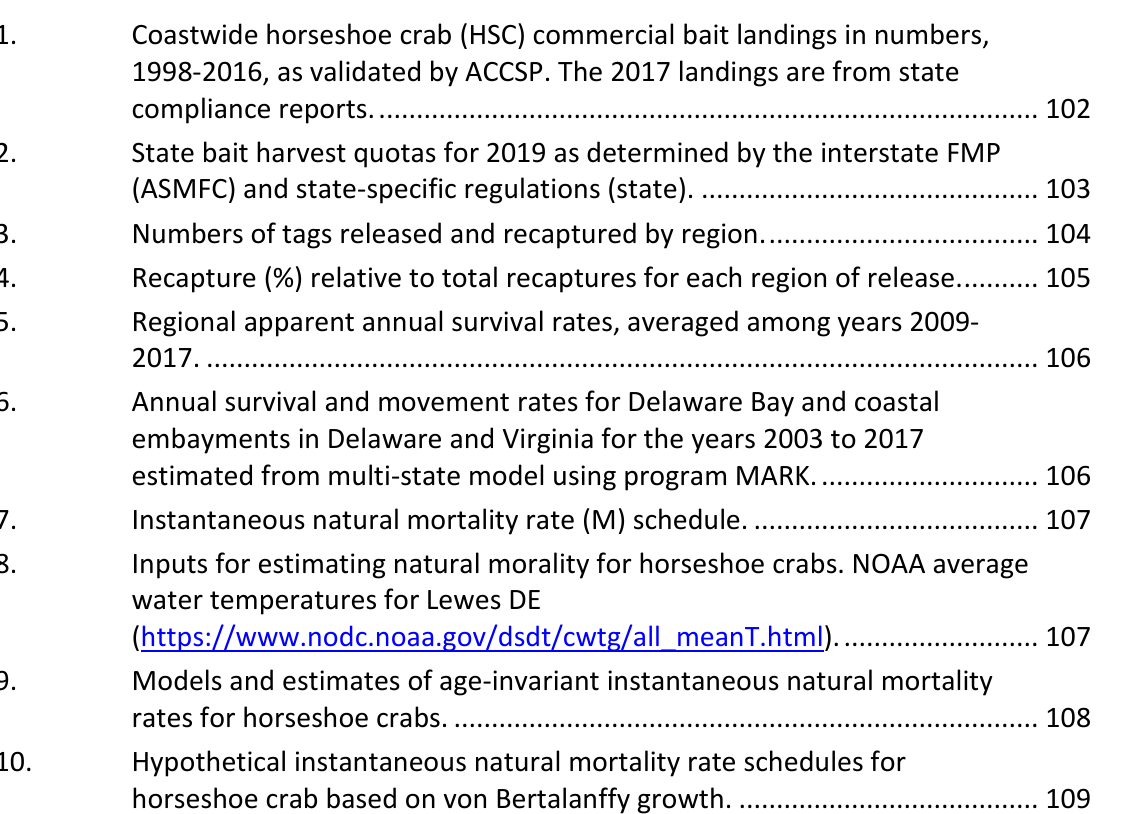
Inputs for estimating natural morality for horseshoe crabs. NOAA average water temperatures for Lewes DE Models and estimates of age-invariant instantaneous natural mortality Hypothetical instantaneous natural mortality rate schedules for Data and results for the Mann-Kendall test of temporal trends in sex ratios, defined as the ratio of males to females. Significant p-values are presented in bold. Trends test not applicable for biomedical data due to the low number of years with sex-specific harvest data. Survey type refers to fisheries independent (FI) and dependent (FD) data. Confidential Sex ratio and proportion female information, along with associated confidence limits, for each survey of available fisheries-independent and Commercial bait landings in numbers of horseshoe crabs by region, 1998- 2016. The four regions are the Northeast (Maine, Massachusetts, Rhode Island), New York (Connecticut, New York), Delaware Bay (New Jersey, Delaware, Maryland, Virginia), and Southeast (North Carolina, South Horseshoe crab commercial bait harvest in numbers for the Delaware Bay states by sex, 1998-2017, validated by ACCSP. The number of female horseshoe crabs of Delaware Bay origin was developed to support the catch survey analysis for that region. See section 4.1.3 for how